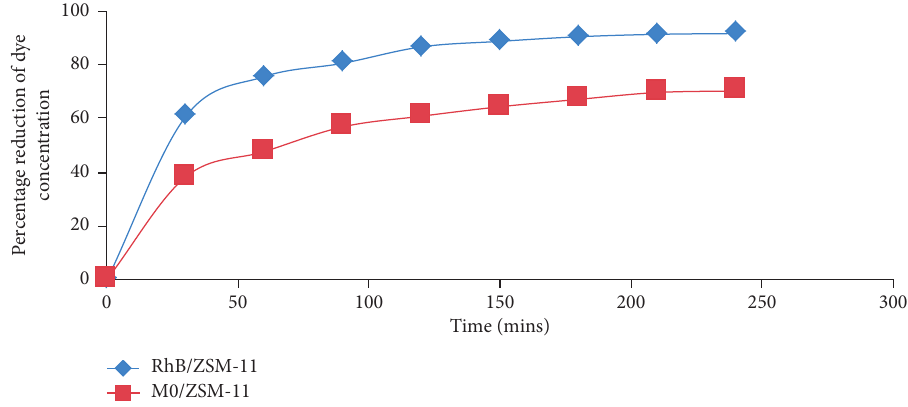
Figure 15: A graph showing the percentage reduction of dyes with time.